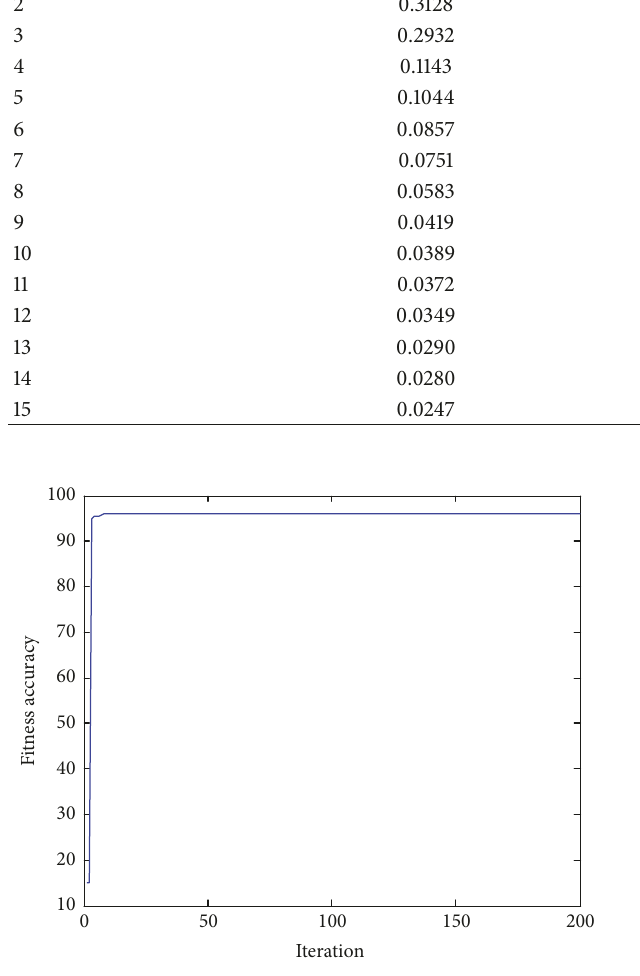
Figure 9: Accuracy with 𝐶 , 𝛾